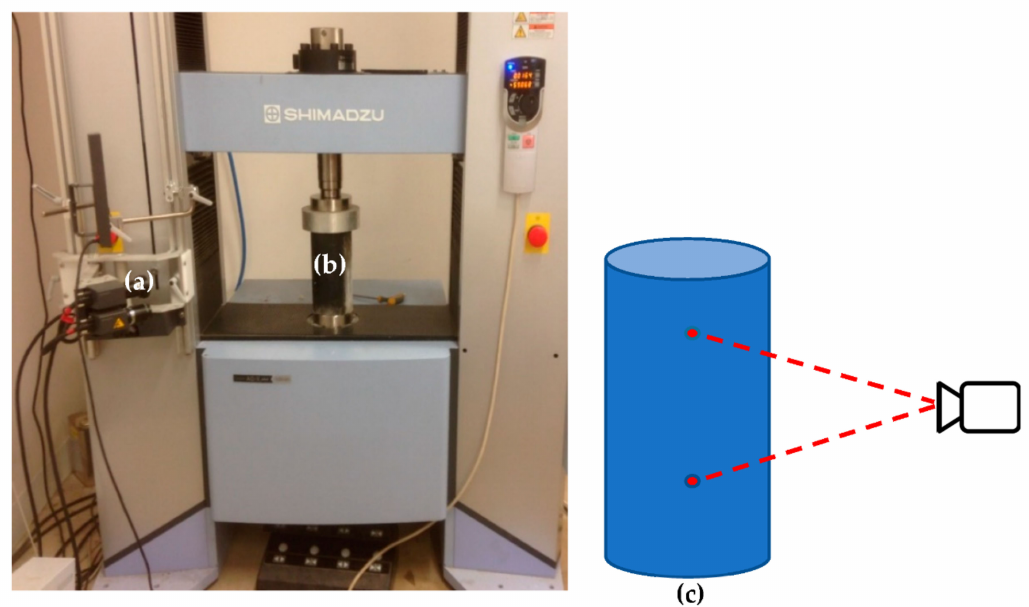
Figure 4. Set up for measuring of elastic modulus: ( a ) Video tracker, ( b ) Sample under load, ( c ) Schematic illustration of video tracking from two reference